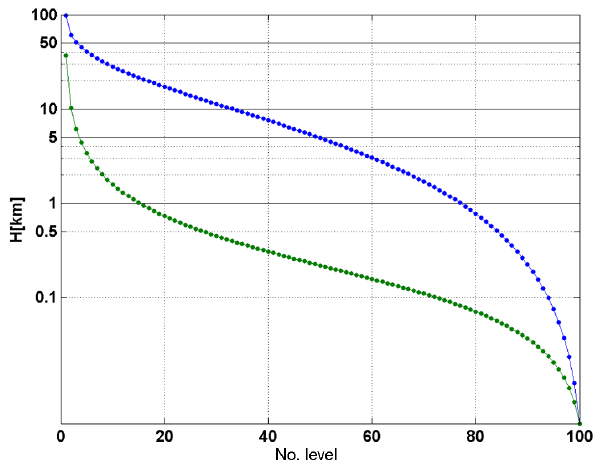
Figure 1. Vertical spacing of profiles levels used for RTTOV in this analysis. Level altitudes and altitude differences between levels are reported respectively with blue and green lines. Note that the y axis is in logarithmic